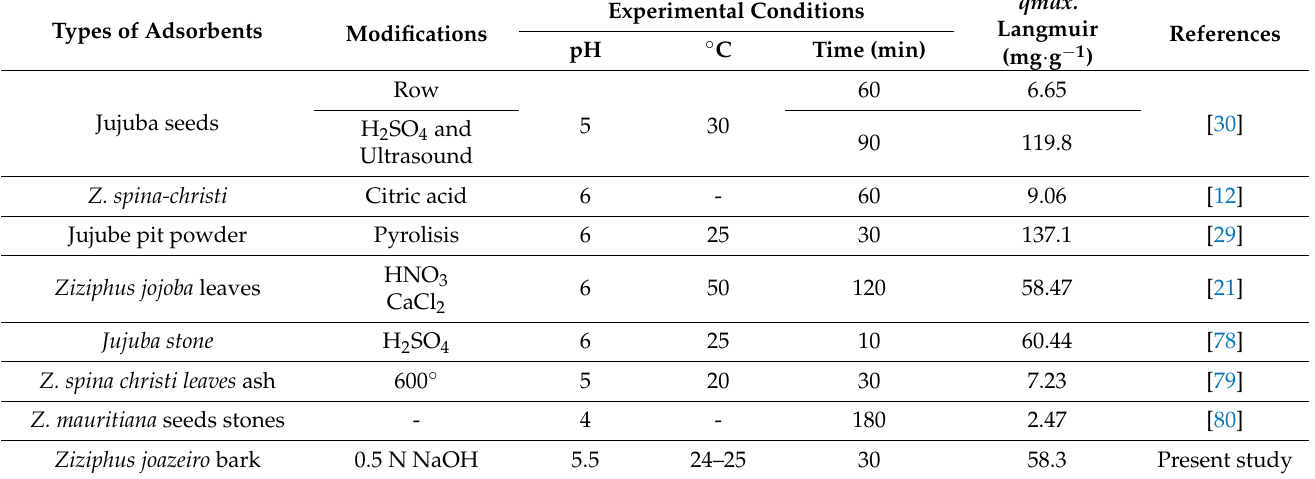
Table 5. Maximum adsorption capacity of Pb(II) ions from different adsorbents from Ziziphus genus by Langmuir